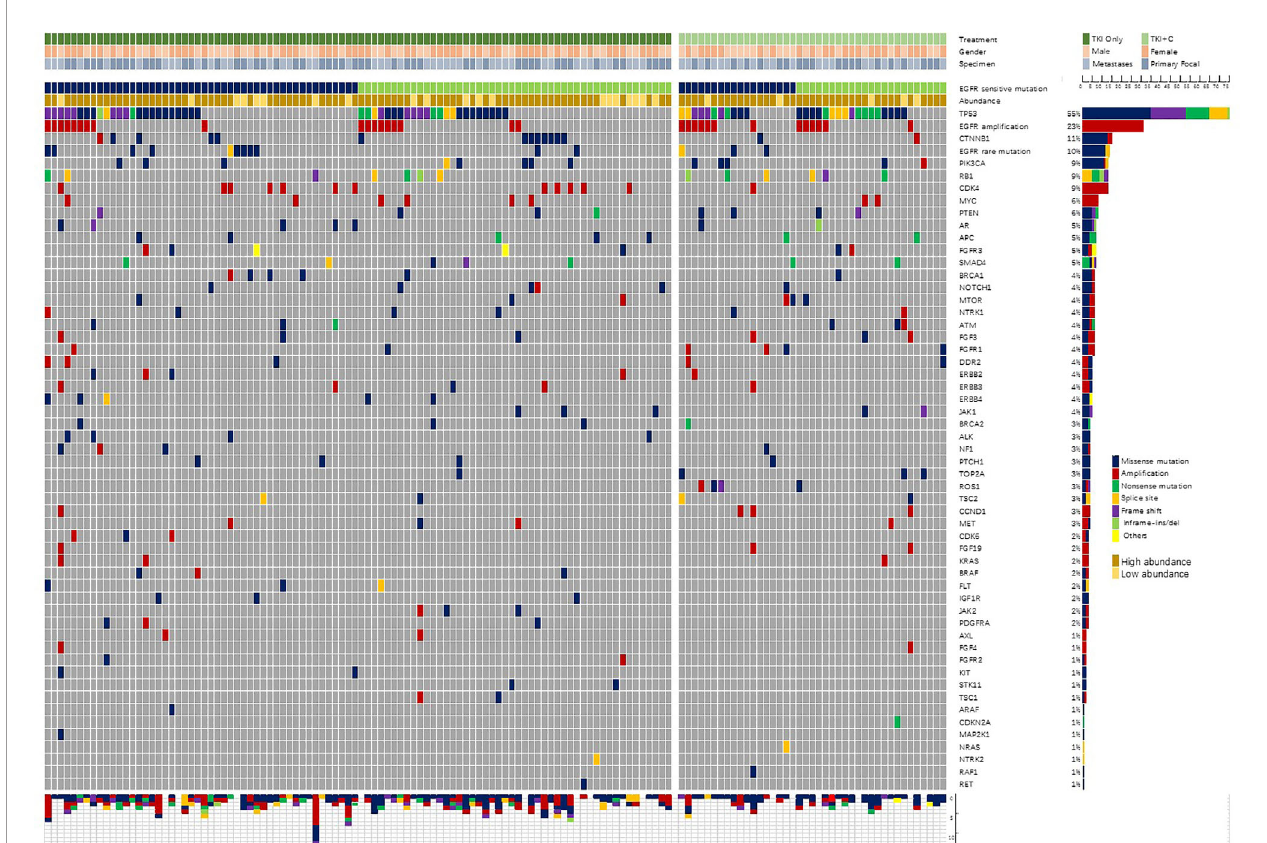
FIGURE 2 | Oncoprint of genomic alterations identi fi ed in baseline tumor tissue (n =